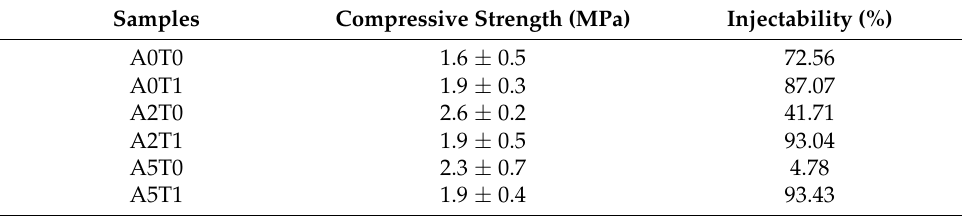
Table 2. Compression strength (after 72 h of incubation) and injectability of the samples. Samples